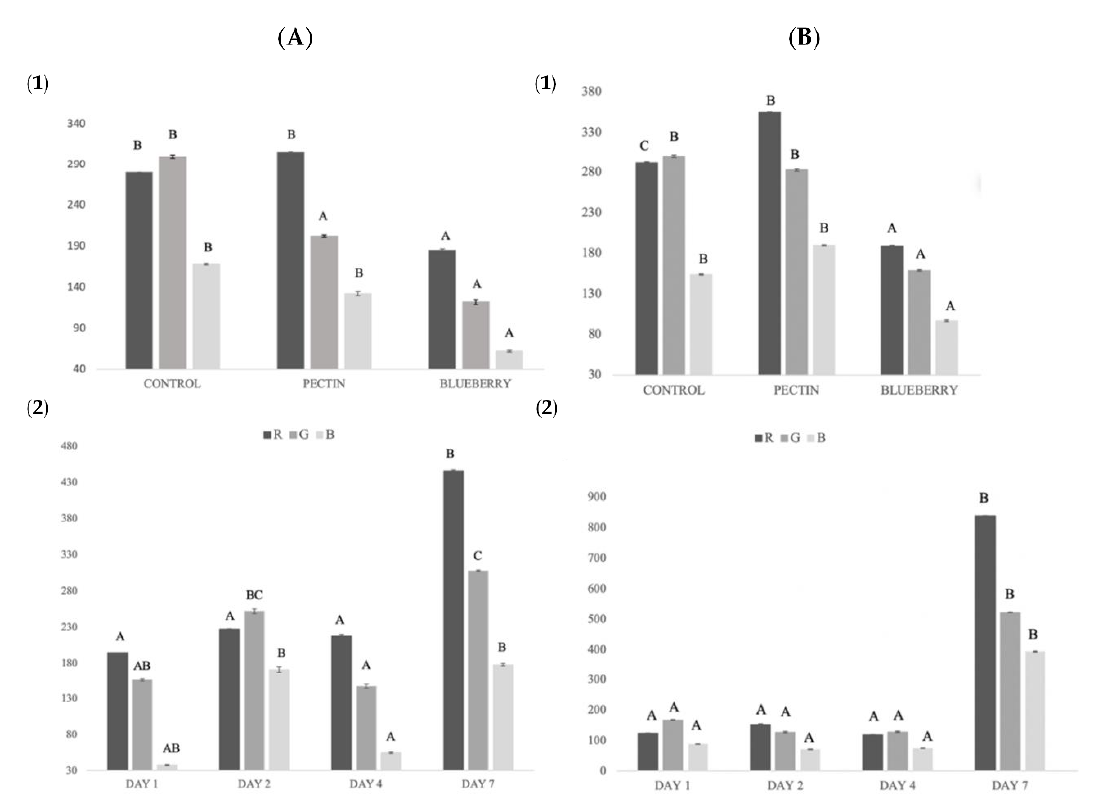
Figure 3. ( A ) Global salmon color changes: ( 1 ) global color for each treatment; ( 2 ) global color during storage. ( B ) Global pectin and blueberry film color changes: ( 1 ) global color for each treatment; ( 2 ) global color during storage. Different capital letters indicate significant differences ( p < 0.05).